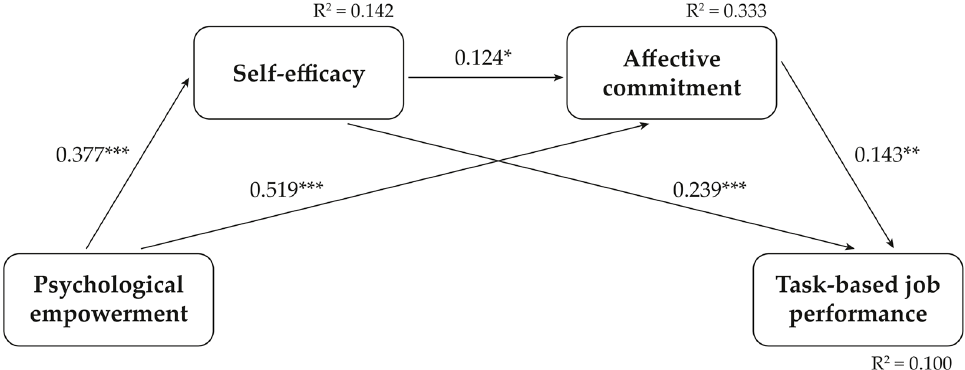
Figure 2. Standardized structural path coefficients. Notes: All endogenous variables are associated with errors, which are not shown in this figure for simplicity. *** p < 0.001; ** p < 0.01; * p < 0.05.